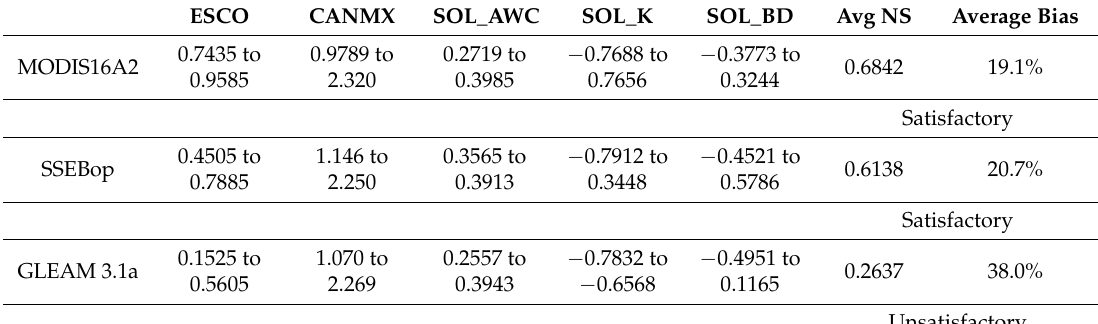
Table 4. Consistently sensitive evapotranspiration (ET) parameter value ranges, Nash–Sutcliffe efficiency (NS) performance, and bias from the Upper North Fork